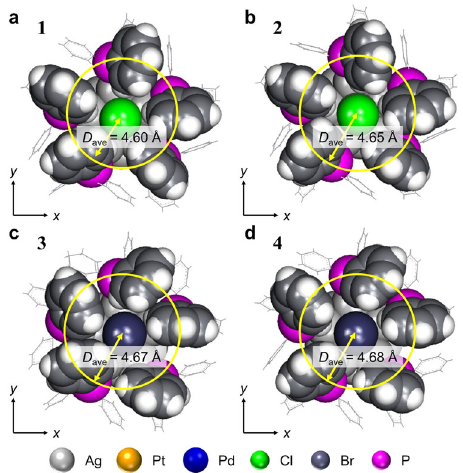
Fig. 3 Structural analysis of the ligand positions. a – d View from the long- axis direction for 1 , 2 , 3 and 4 , respectively, showing the average distance between the central long axis and the positions of the P atoms (Dave) (grey = Ag; orange = Pt; blue = Pd; green = Cl; dark grey = Br; magenta = P). The geometric structures of 1 and 2 are reproduced from ref. 28,31 ,